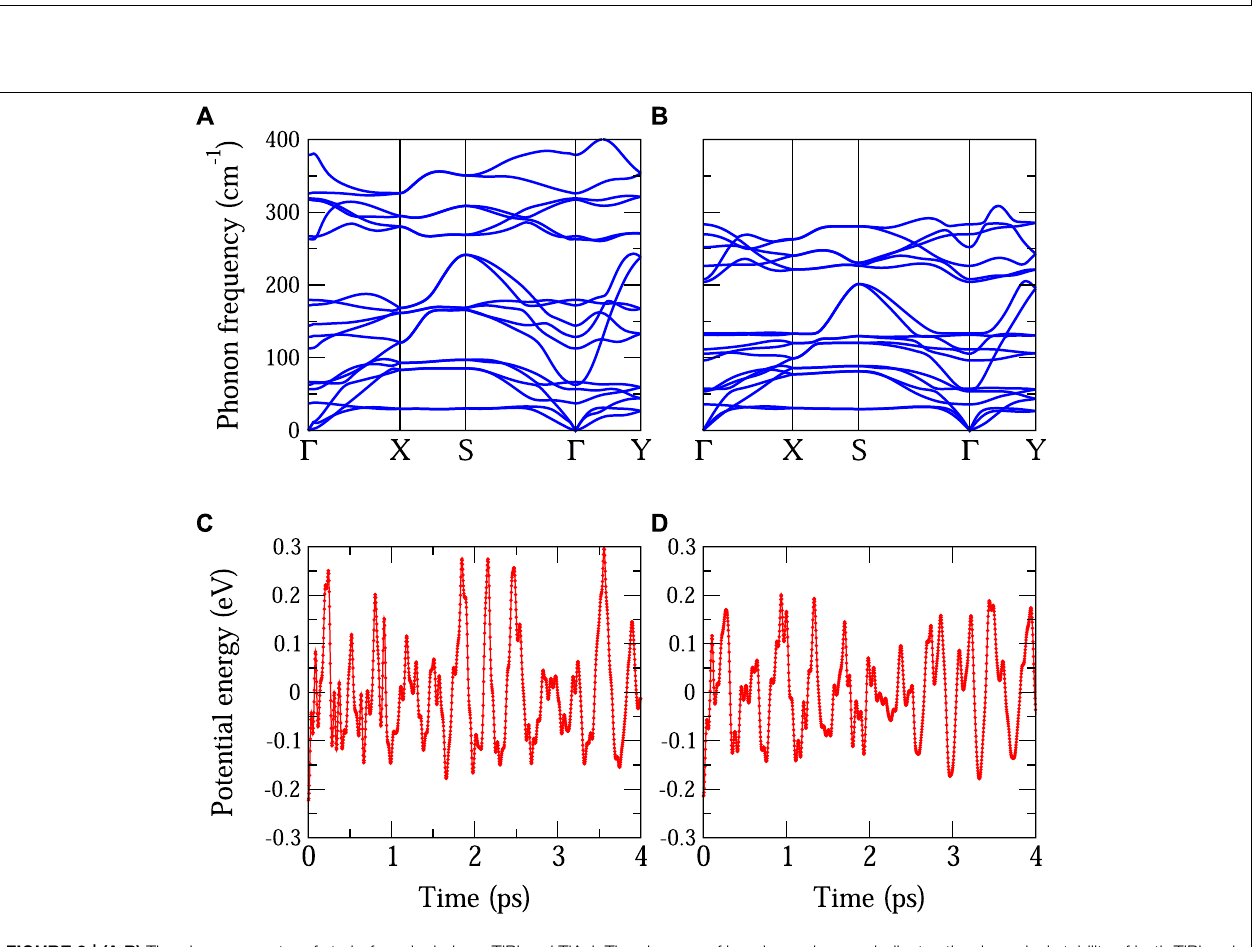
Frontiers in Materials |